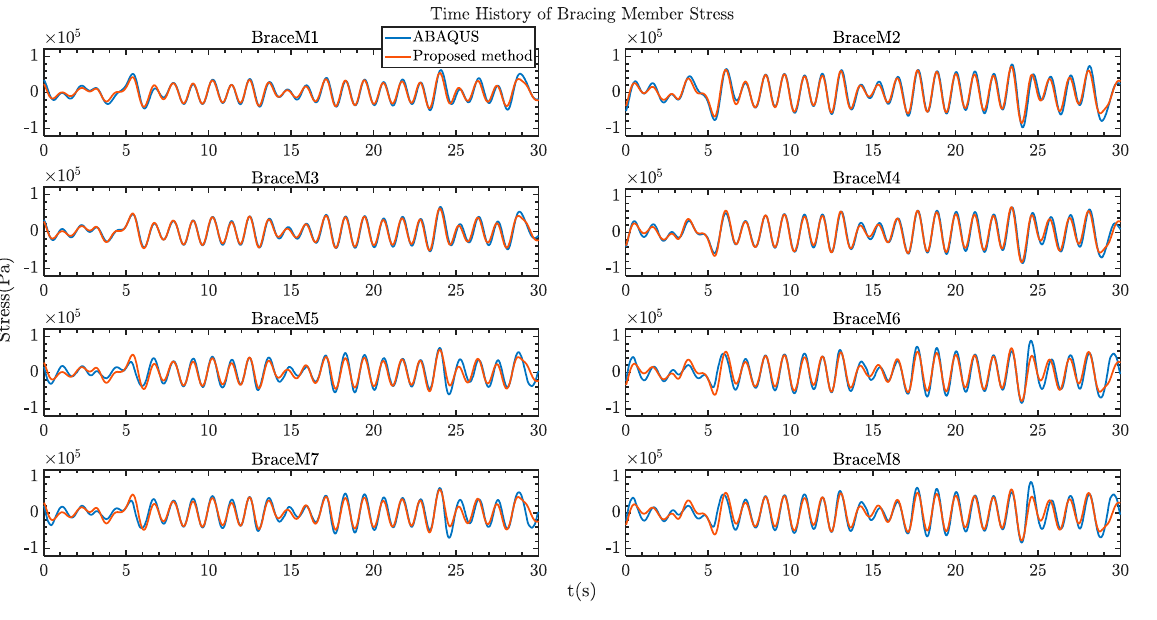
Figure 13. Comparison of the time history of stresses for chord members along forward leg of the SEU under irregular wave excitations.